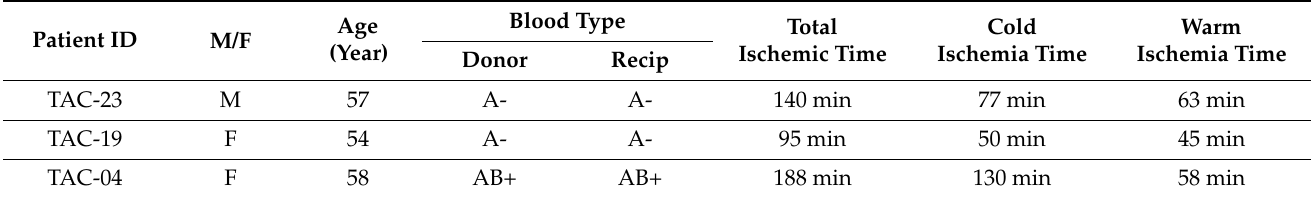
Table 2. Patients’ characteristics.